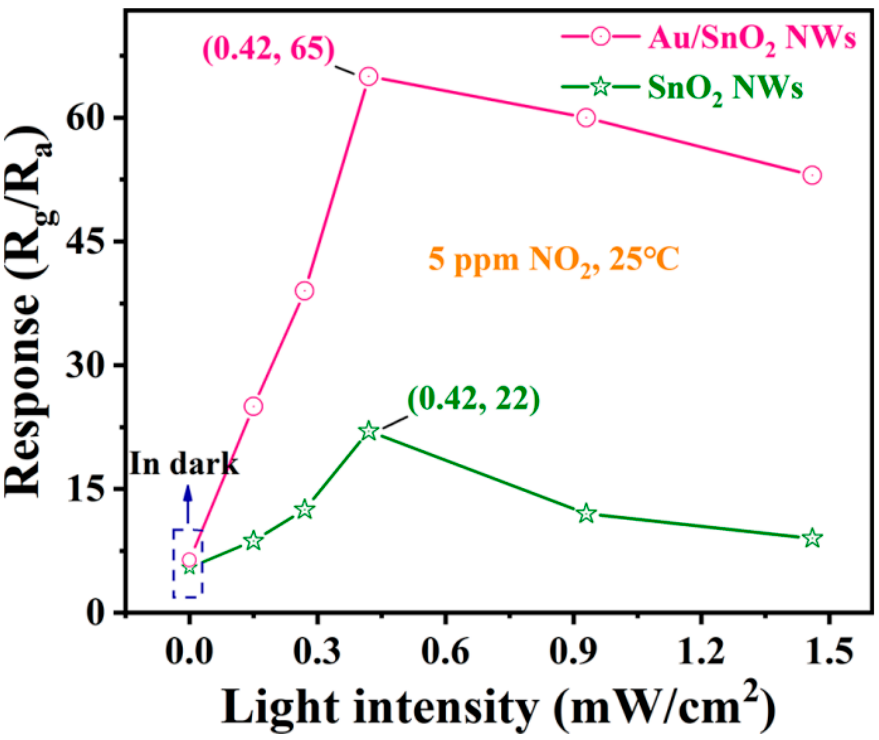
Figure 5. Responses of sensors based on SnO 2 and Au/SnO 2 NWs toward 5 ppm NO 2 at RT in the dark or under UV irradiation with incremental light intensity.